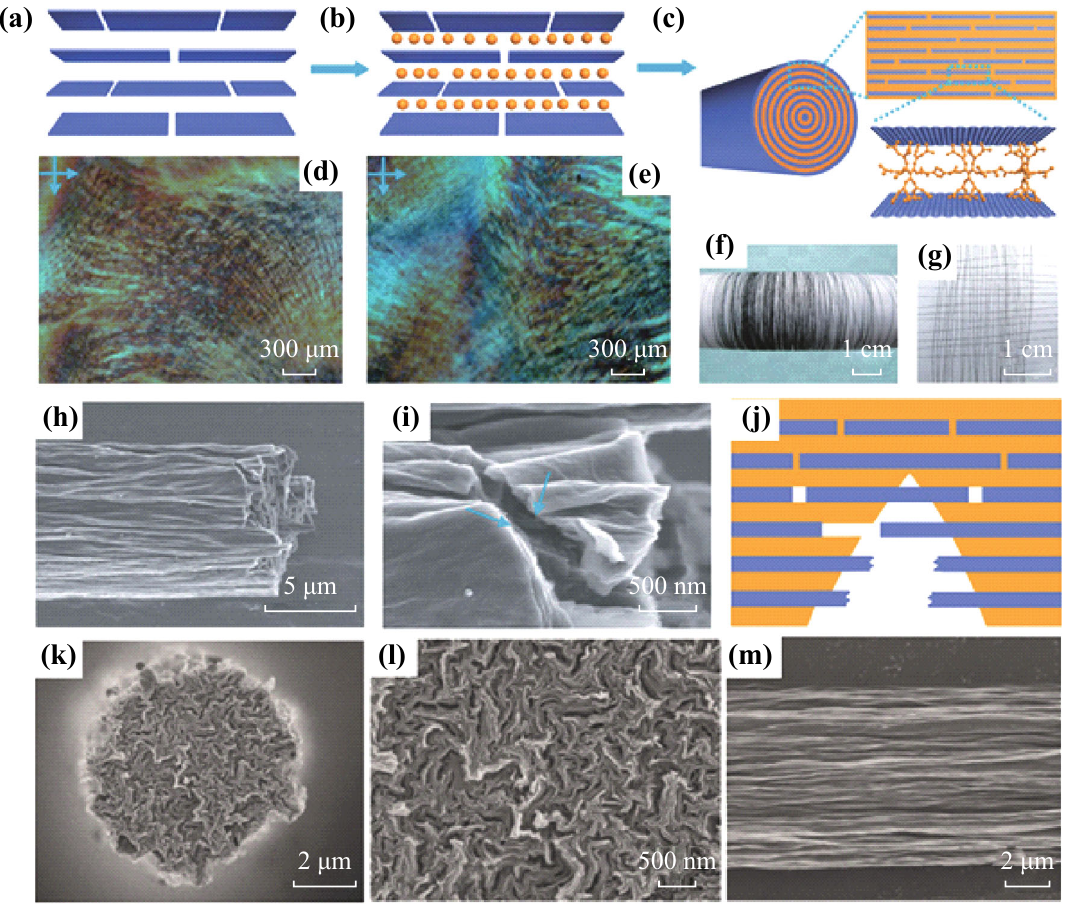
Fig. 13 Schematic illustration of LCST strategy a – e and the resulting composite fibers ( f , g ). Morphology of fracture section of GO-HPG fibers h , j and deformation mechanism model under tensile. SEM images of the cross section k , l and lateral view m of a GO-SA fiber. a – j Reproduced with permission from Ref. [60]. Copyright 2014, Nature Publishing Group. k – m Reproduced with permission from Ref. [62]. Copyright 2016,